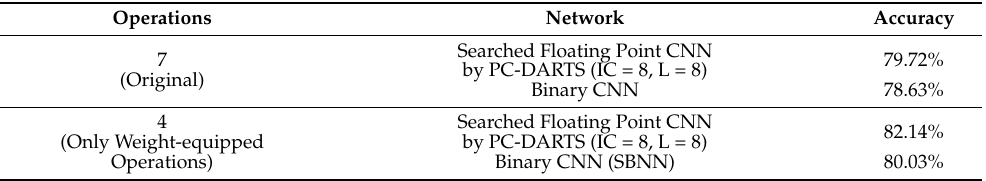
Table 10. Comparison of different candidate operations.